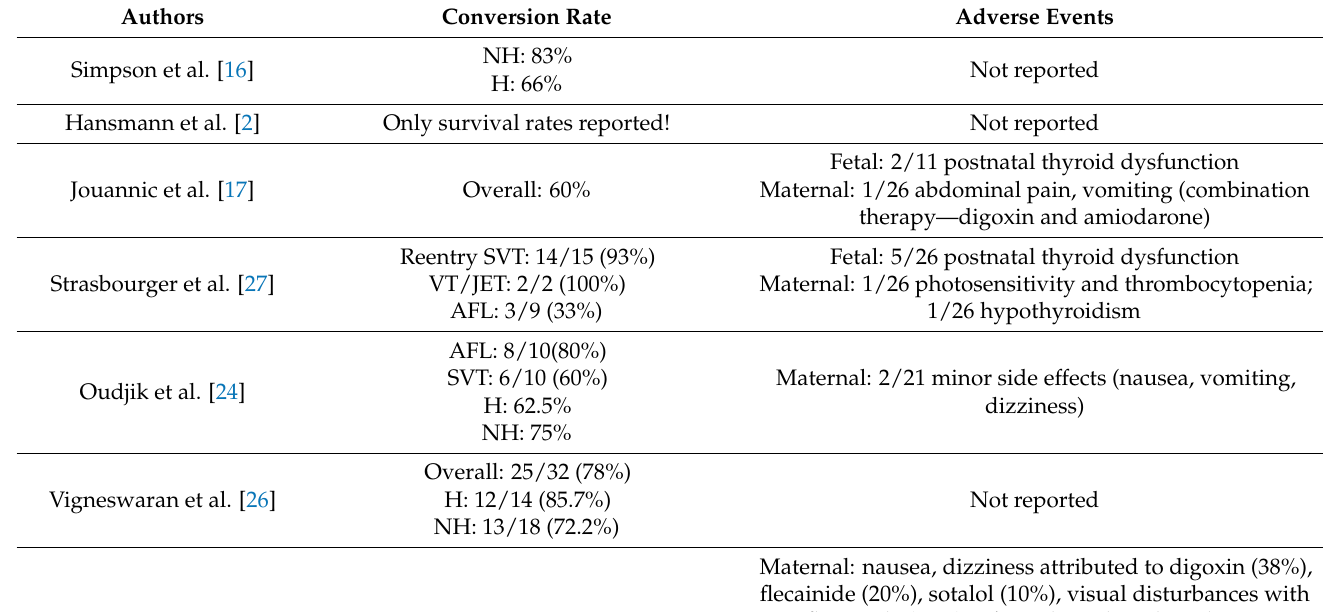
Table 3. Summary of study protocols found in the literature